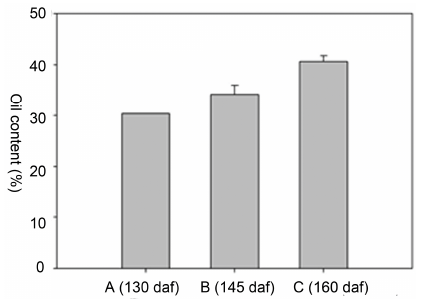
Figure 2. The oil content (%) in tung seeds of three developmental stages. A, B and C represent the seeds harvested on 25 August, 9 September and 26 September, respectively. Table 1. Changes in the fatty acid composition (%) of tung tree seed oil in the three developmental stages. Fatty Acid Time Palmitic Acid Stearic Acid Oleic Acid Linoleic Acid Linolenic Acid